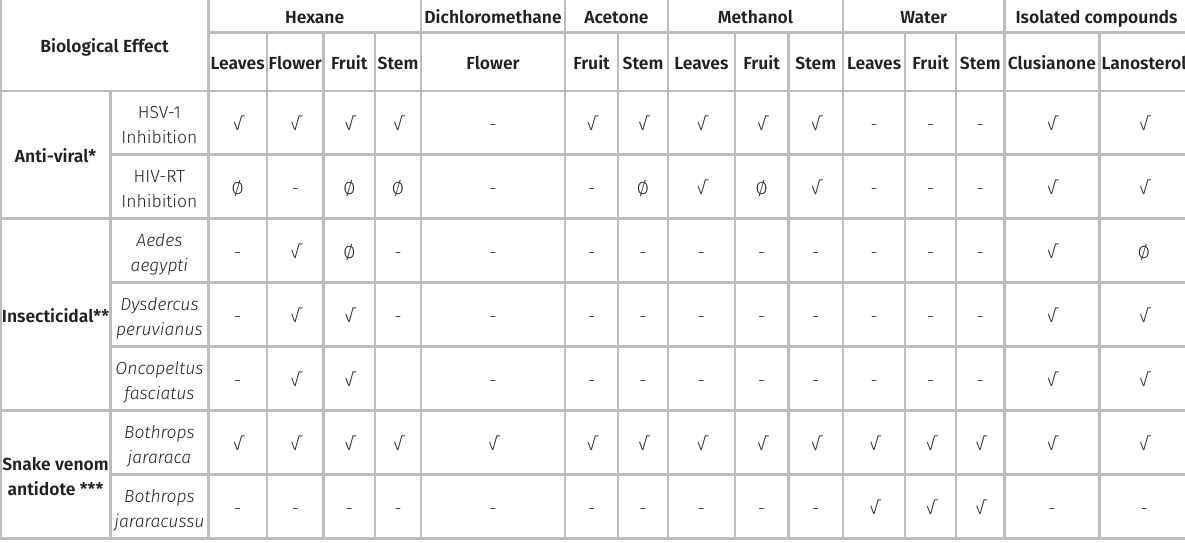
Table II. Overview of the biological activity of Clusia fluminensis extracts and isolated